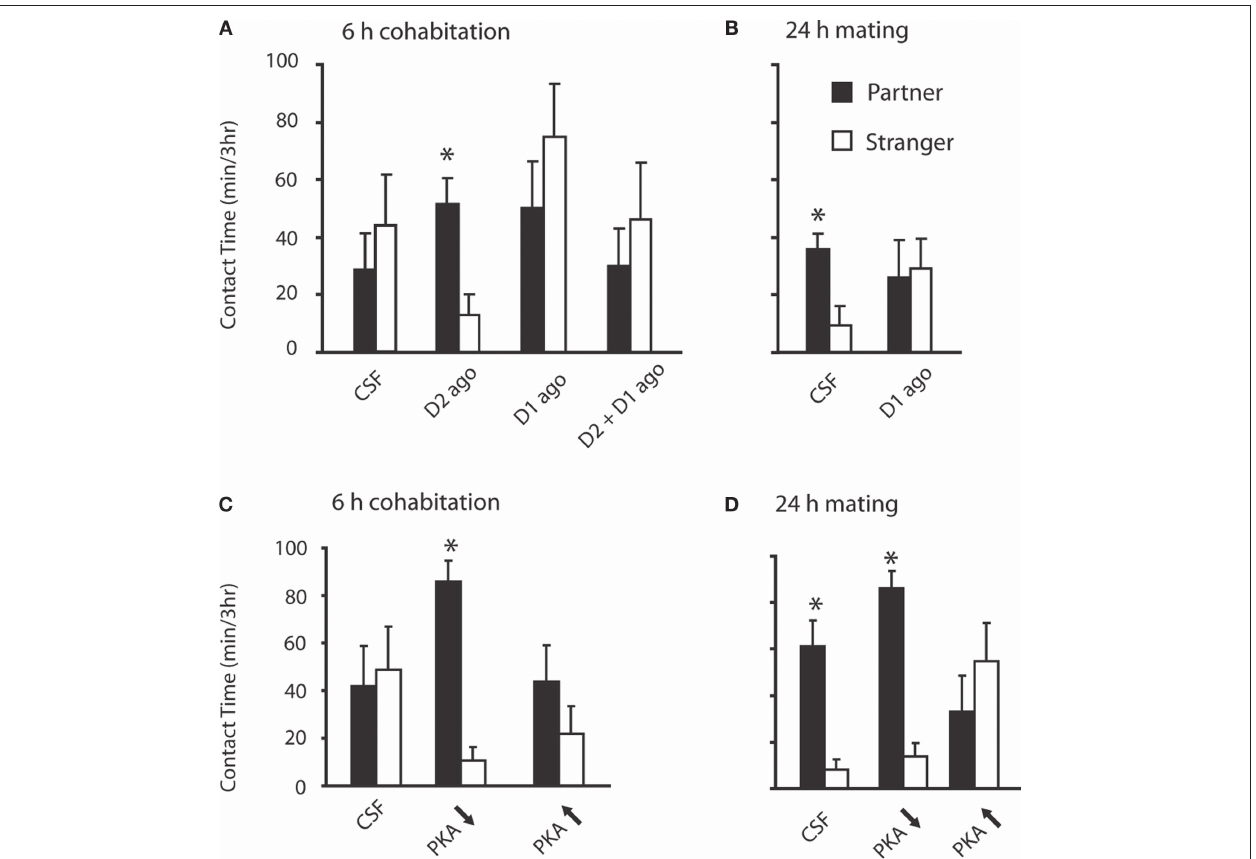
FIGURE 3 | Opposing regulation of pair bond formation by D2- and D1-like dopamine signaling systems within the NAc shell. (A) Activation of D2-like receptors within the NAc shell by micro-infusion of the D2-specifi c agonist quinpirole (D2 ago) induced partner preferences in the absence of mating. Activation of D1-like receptors within the shell using the D1-specifi c agonist SKF 38393 (D1 ago) failed to induced partner preference formation and prevented quinpirole-induced partner preferences. (B) Activation of D1-like